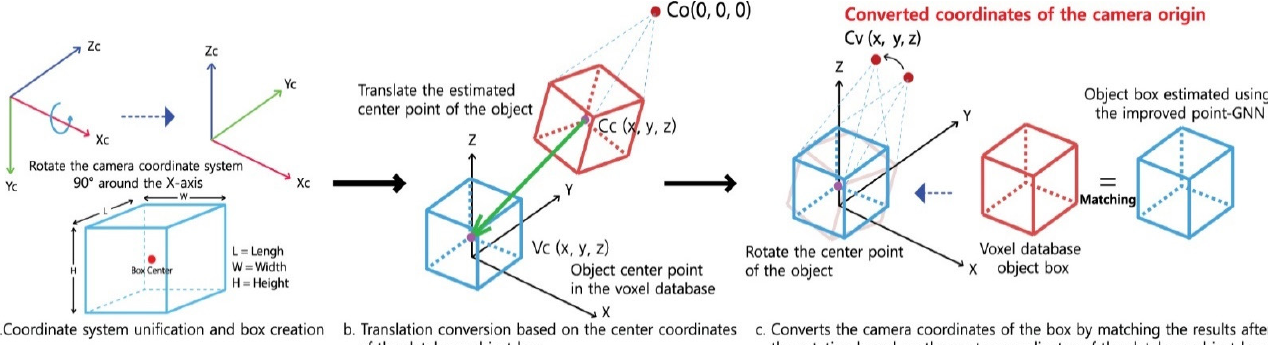
( b ) Figure 3. The Voxel database in the point cloud comprises ( a ) voxel grids and ( b ) corners of a box. 3.2.2. Matching the Object Pose Estimated by Deep Learning with that in the Voxel